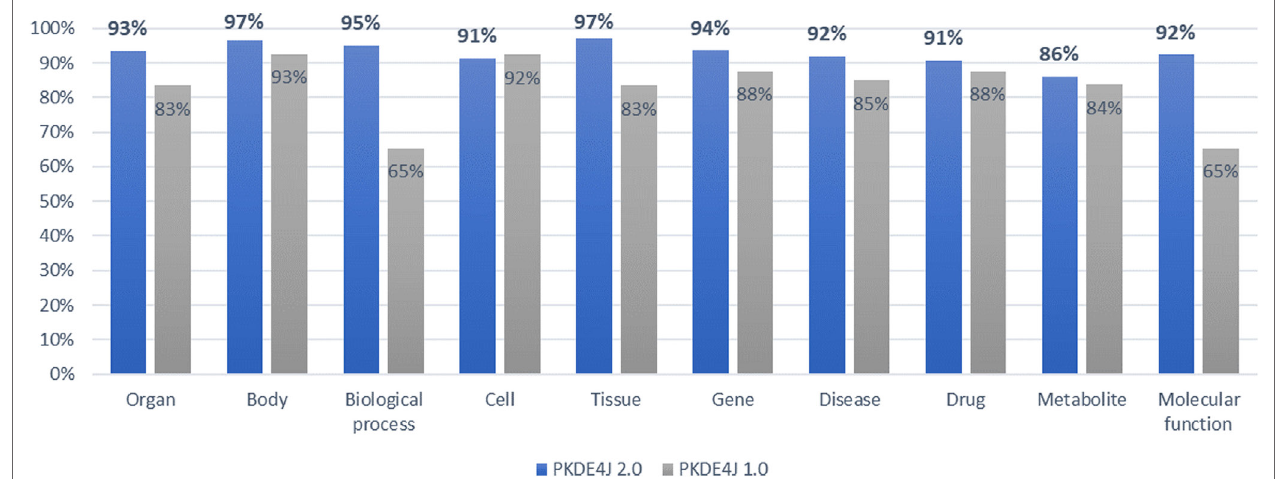
FigUre 7 | Comparative evaluation ( F -score) of dictionary-based named entity recognition by type of biomedical